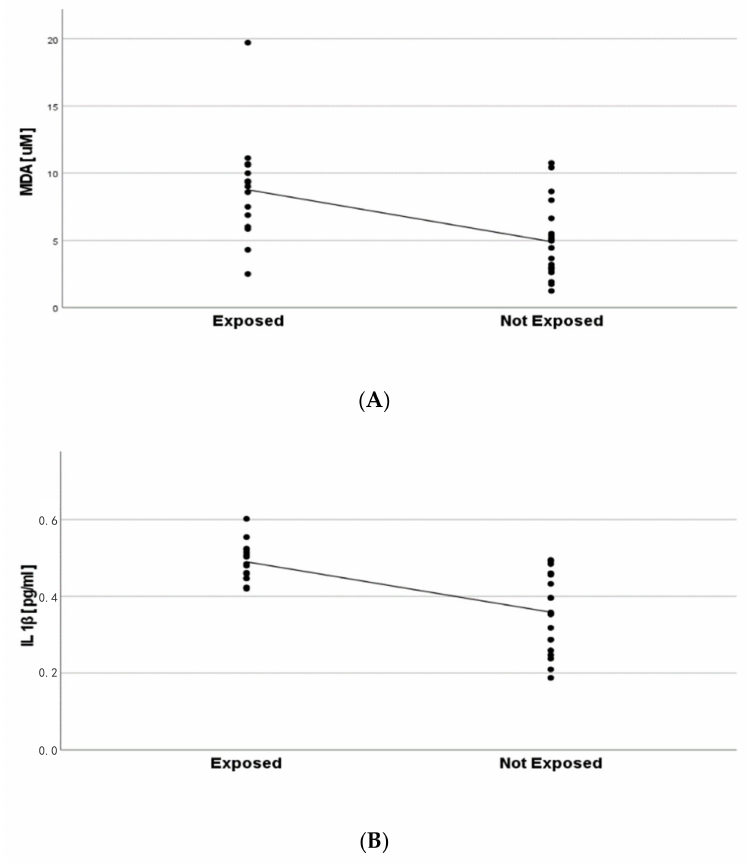
Figure 5. Regression model between working exposure and MDA (urine gold standard) ( A ) and IL1 β (EBC gold standard) ( B